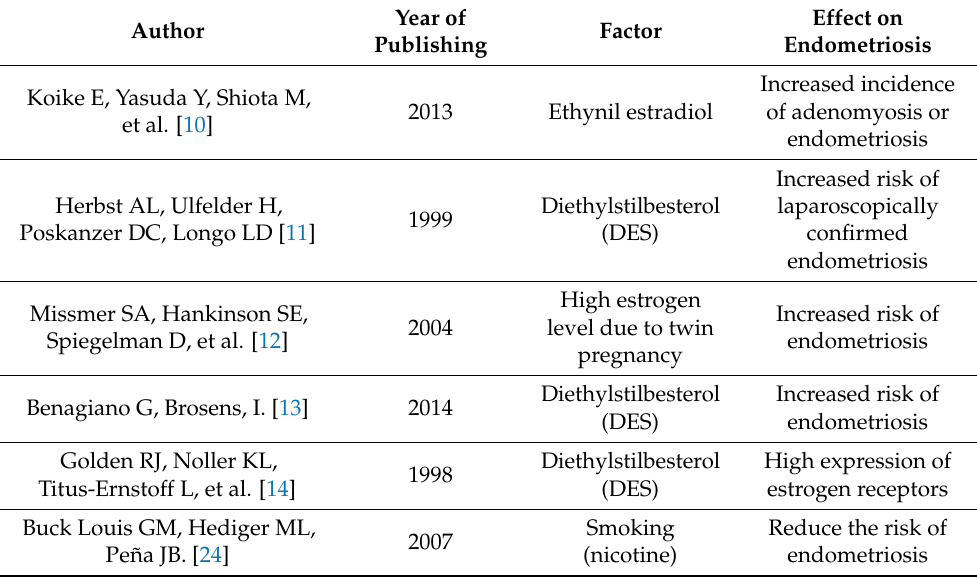
Table 1. In-utero factors of